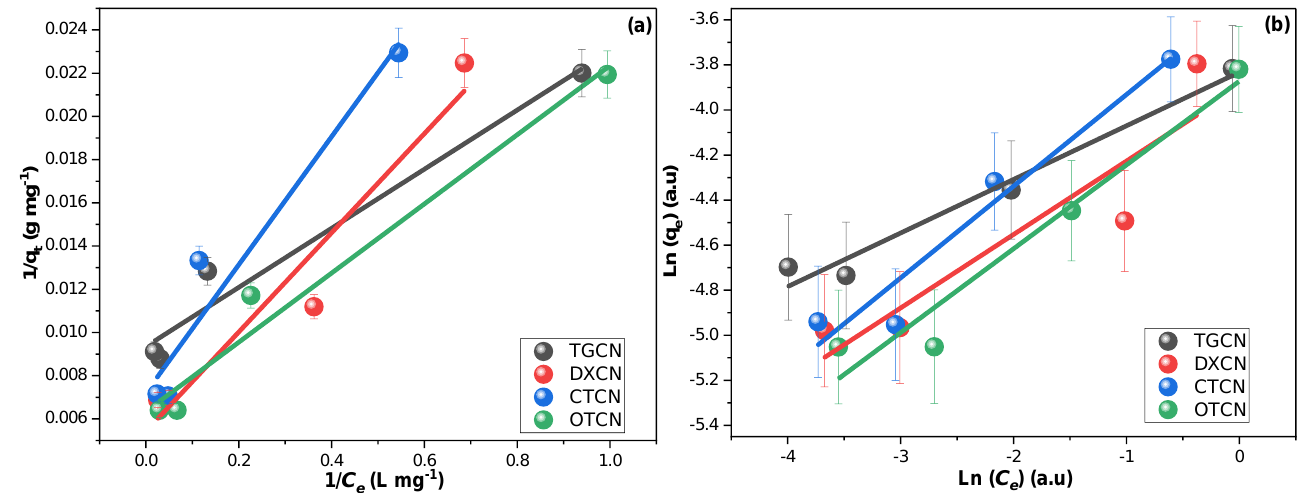
where K l (L mg − 1 ) is LIM constant, K f (L mg − 1 ) is FIM constant; C e (mg L − 1 ) is the equilibrium solution concentration, q m is the computed-maximum-sorption capacity, while the 1/ n is Freundlich-adsorption-intensity [79]. Figure 7 illustrates the linear fittings of LIM and FIM investigations for TGCN, DXCN, CTCN, and OTCN sorption on the fabricated CRNPs.